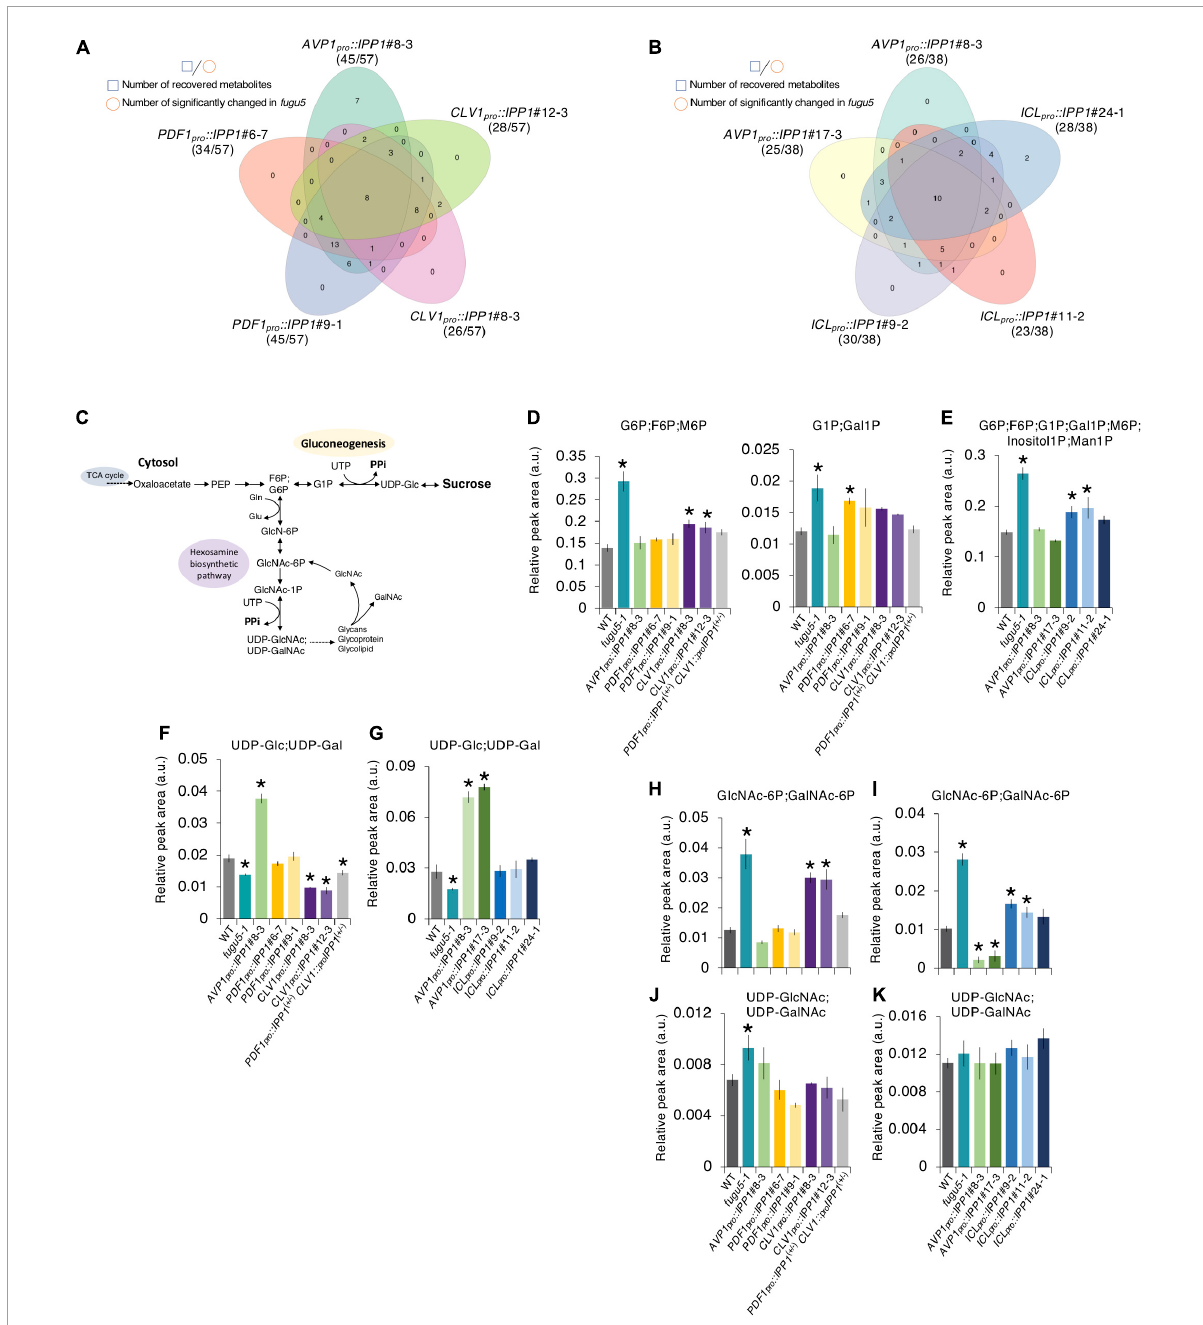
FIGURE7 Effect on the metabolite profile of spatiotemporal expression of IPP1 on the fugu5 background by capillary electrophoresis time-of-flight mass spectrometry (CE-TOF MS). (A,B) Venn diagram of metabolites that recovered to wildtype (WT) levels and those that exhibited opposite and significant fluctuations in fugu5 vs. the indicated transgenic lines. (C) Schematic of the gluconeogenesis pathway targeted by inorganic pyrophosphate (PPi) overaccumulation in fugu5-1 and the hexosamine biosynthetic pathway. (D–K) Fluctuations in major key metabolites in the indicated genotypes. Data are means ± SD ( E , F , H , and J: n = 3; E , G , I , and K: n = 4). *Significant difference at p < 0.05 compared to the WT (Tukey’s HSD